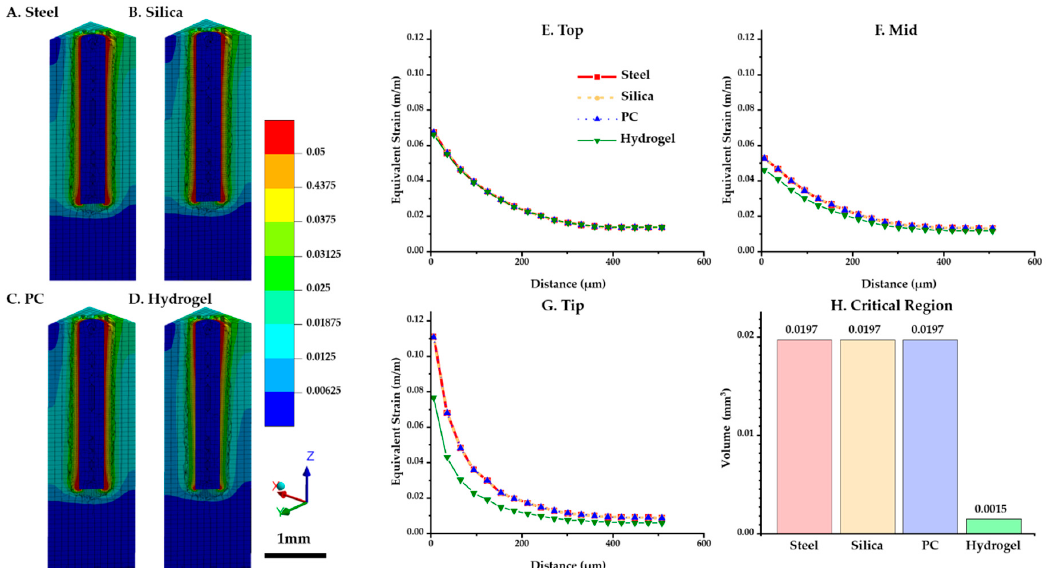
Figure 5. Equivalent strain variation versus time with varying probe materials: steel, silica, PC, and hydrogel (coefficient of friction (COF): 0.3). ( A ) Maximum equivalent strain; ( B ) averaged equivalent strain in the ROI.